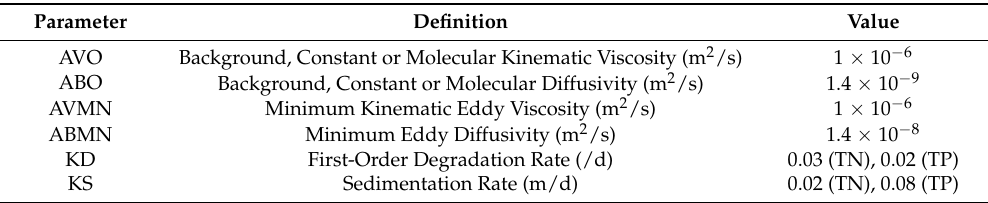
Table 2. Main parameters of the hydrodynamic water-quality